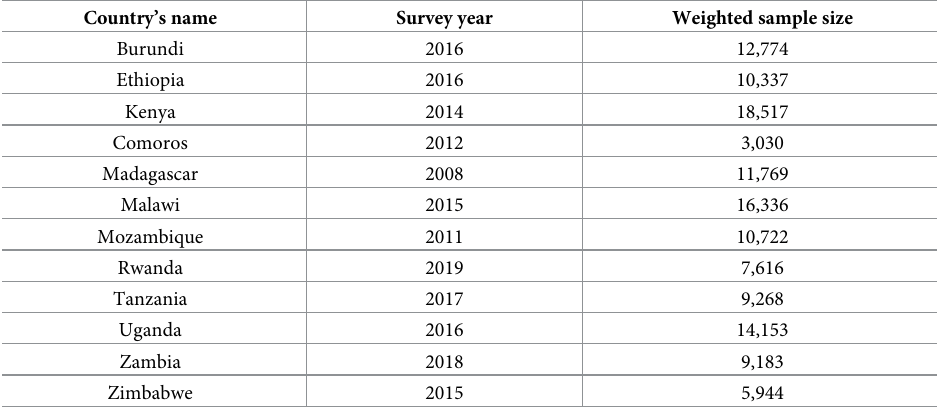
Table 1. Survey years of each country with respective weighted sample